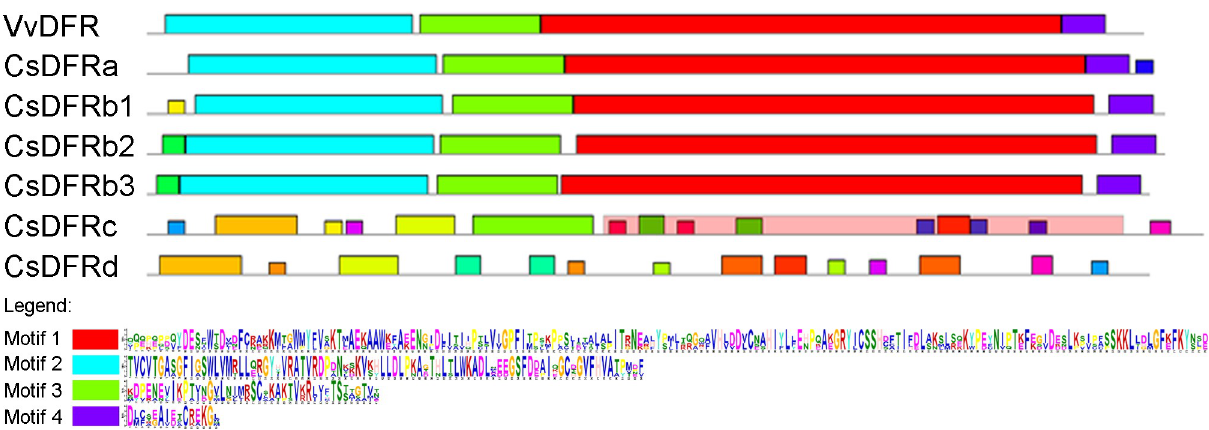
Fig 3. Conserved motifs of putative CsDFR proteins (VvDFR was also displayed as a reference). The colored boxes represent different motifs and their position in proteins. Out of 20 conserved motifs analyzed by MEME, four motifs are significant (E-value < 0.01) and illustrated in the legend.